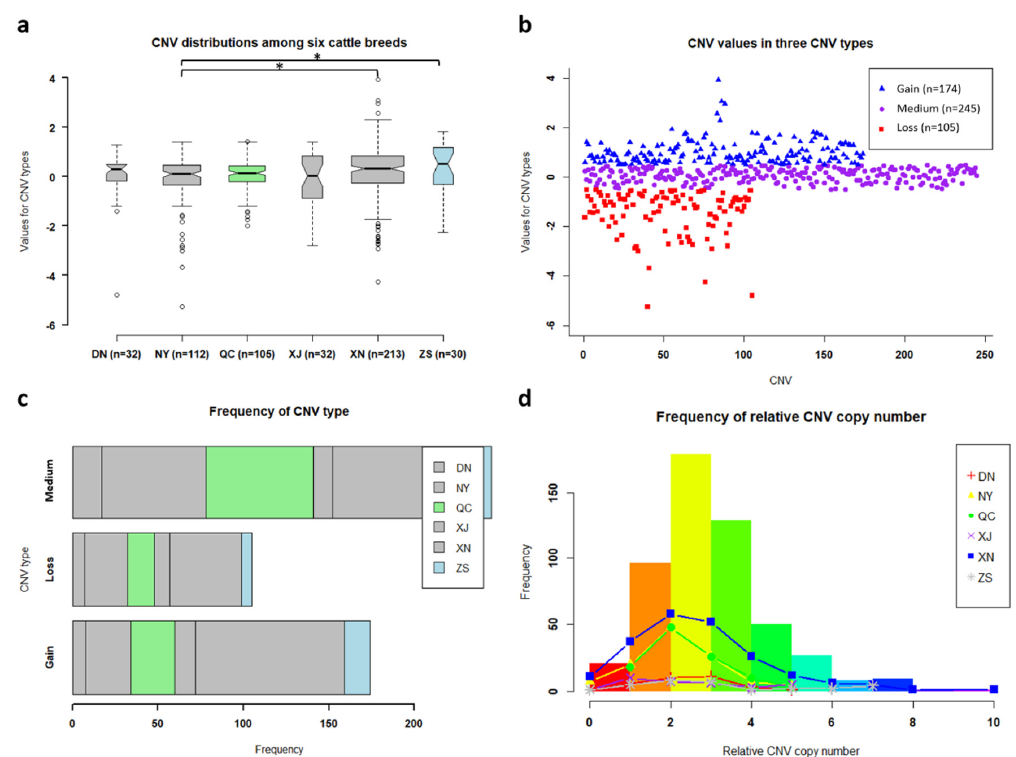
Figure 3. Copy number variations (CNVs) of GBP6 . Note: SE: standard error; DN: Denan breed; NY: Nanyang breed; QC: Qinchuan breed; XJ: Xiajia breed; XN: Xianan breed; ZS: Zaosheng breed. ( a ) The distributions and statistics of CNV type values of GBP6 among six cattle breeds. Note: * indicates adjusted P value < 0.05 according to Student’s t -test after multiple testing correction using false discovery rate (FDR). ( b ) Scatter plots of CNV type values in three CNV types (i.e., gain, medium and